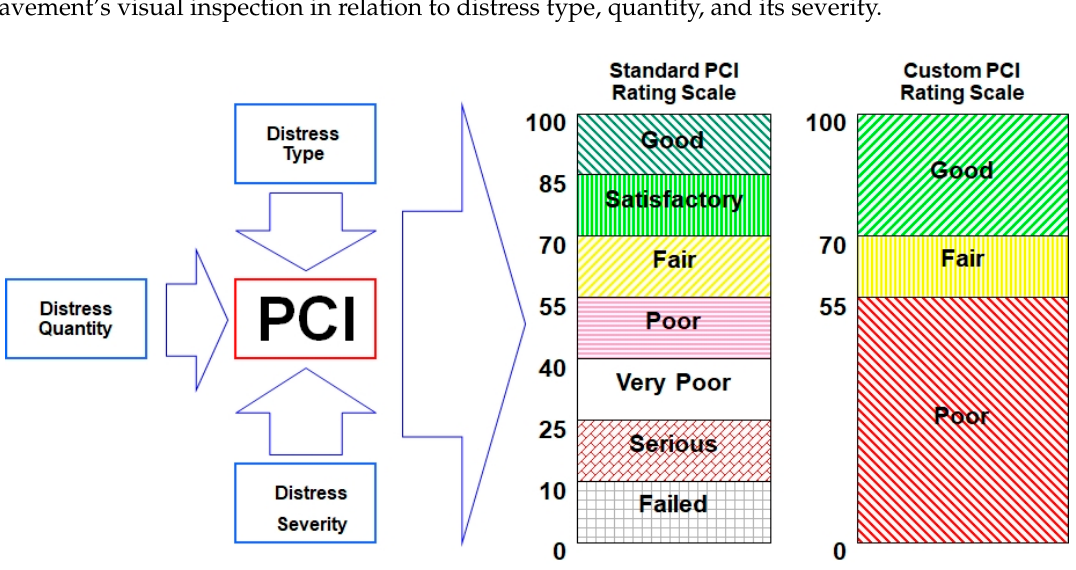
Figure 1. Pavement Condition Index (PCI) rating scale [13].